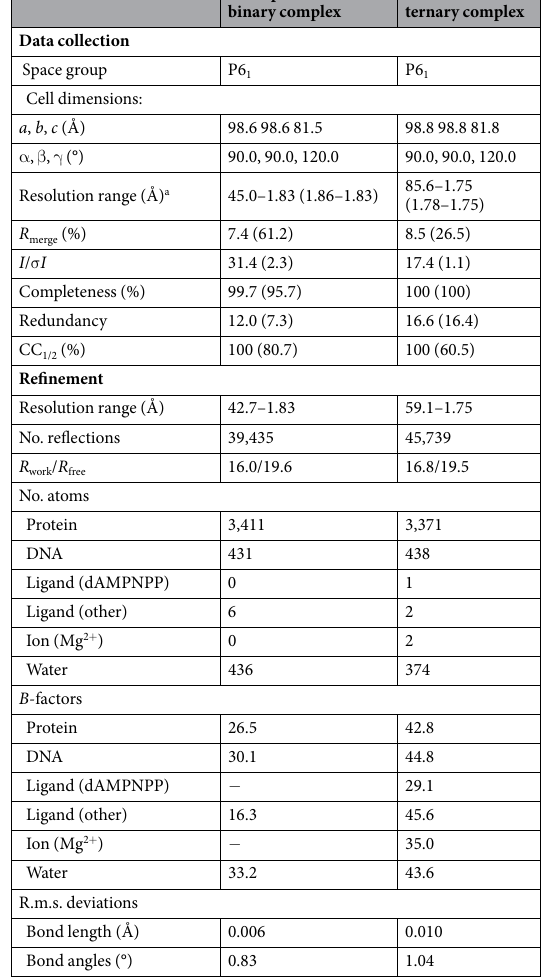
Table 1. X-ray data collection and refinement statistics. a Values in parentheses are for highest-resolution